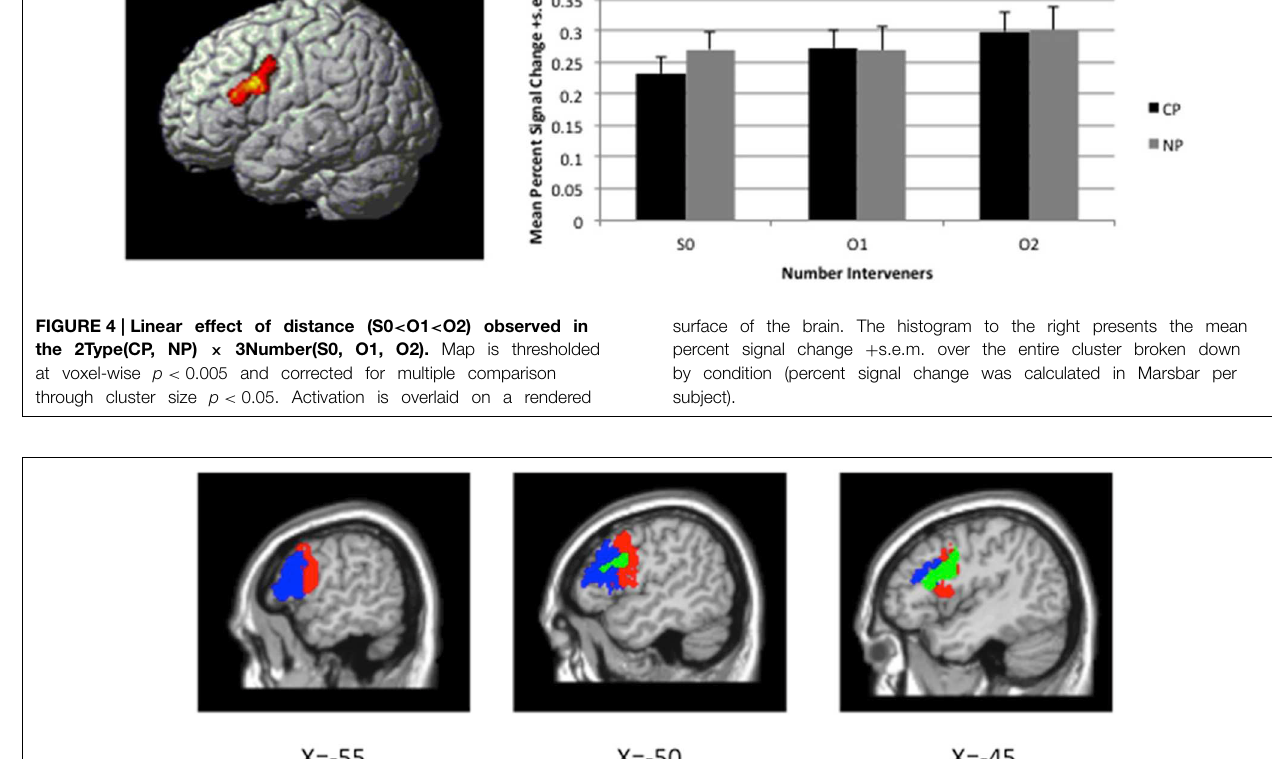
FIGURE 5 | Cytoarchitectonic probability maps of BA 44 (red) and BA 45 (blue) thresholded at 30% overlap overlaid on canonical average brain and linear main effect (voxel-wise p < 0 . 005 , cluster-level p < 0 . 05 ; green) overlaid on top.